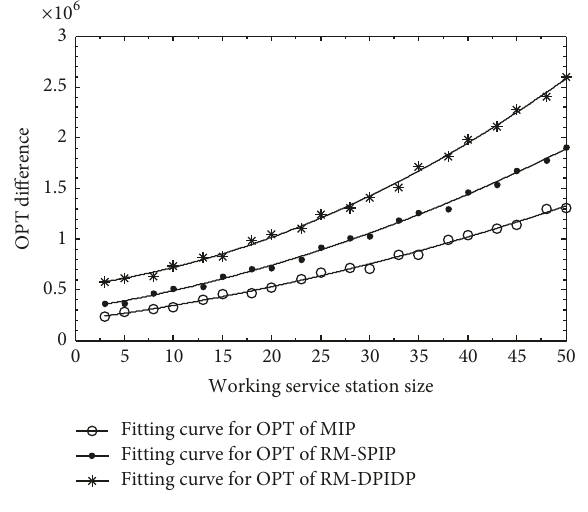
Figure 7: Fitting curve of OPT for 3 models.